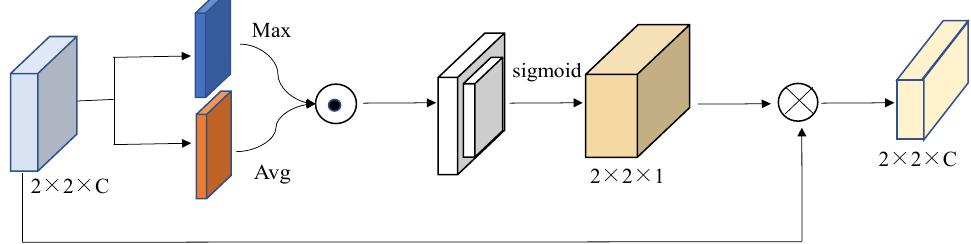
Figure 2. Spatial-Attention